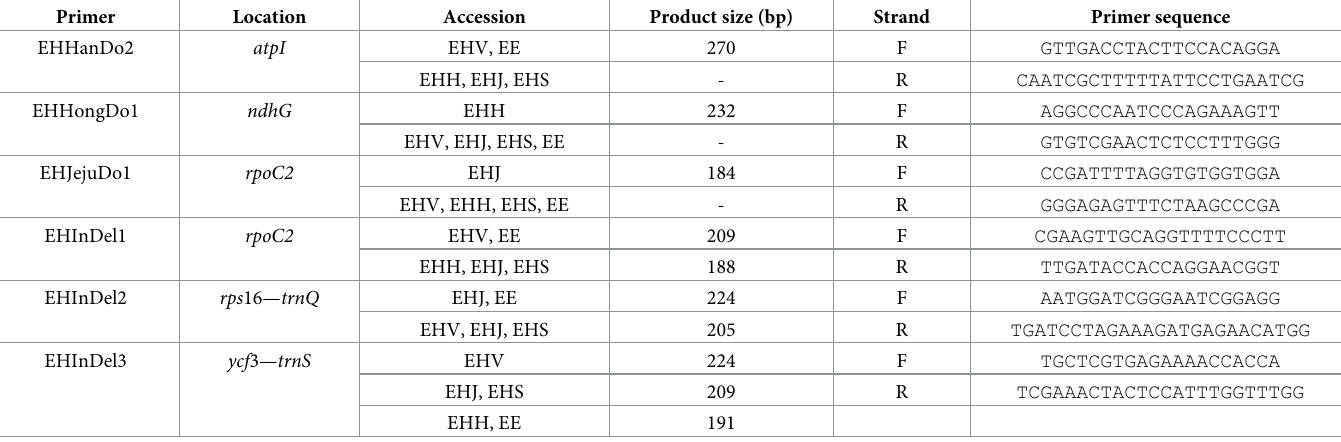
In this study, we assembled the 45S rDNA and 5S rDNA transcription units with their ITS and IGS regions. The 45S rDNA transcription unit showed higher similarity than the ITS regions Table 4. Primers used in this study. Primer Location Accession Product size